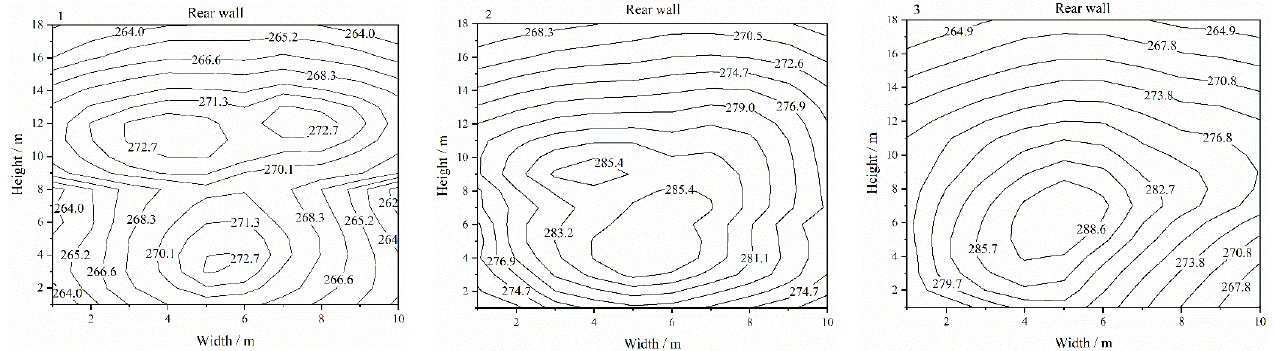
Figure 4. Distributions of the metal temperature (°C) on the rear wall: ( 1 ) case 7, ( 2 ) case 8, and ( 3 ) case 9.